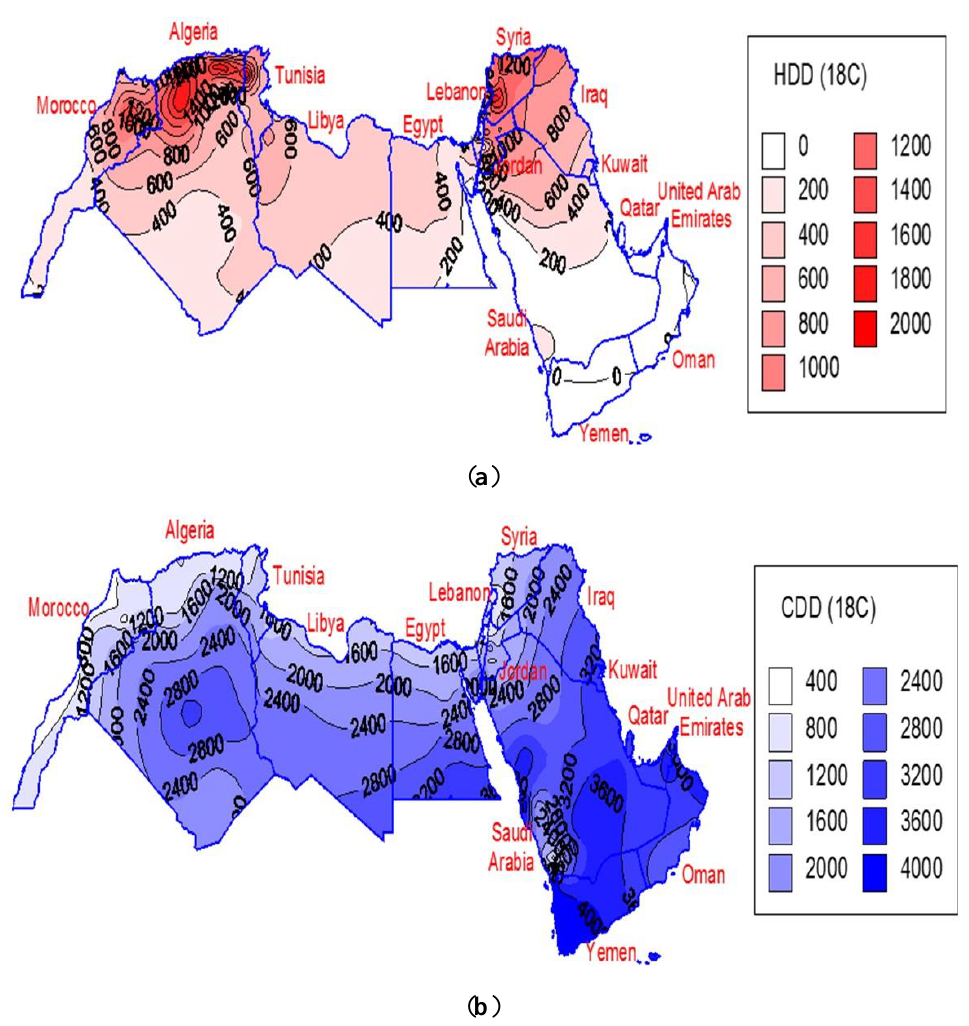
Figure 7. Contour map of Arab region for annual ( a ) heating and ( b ) cooling degree-days with a base temperature of 18 °C (Source: [10]).